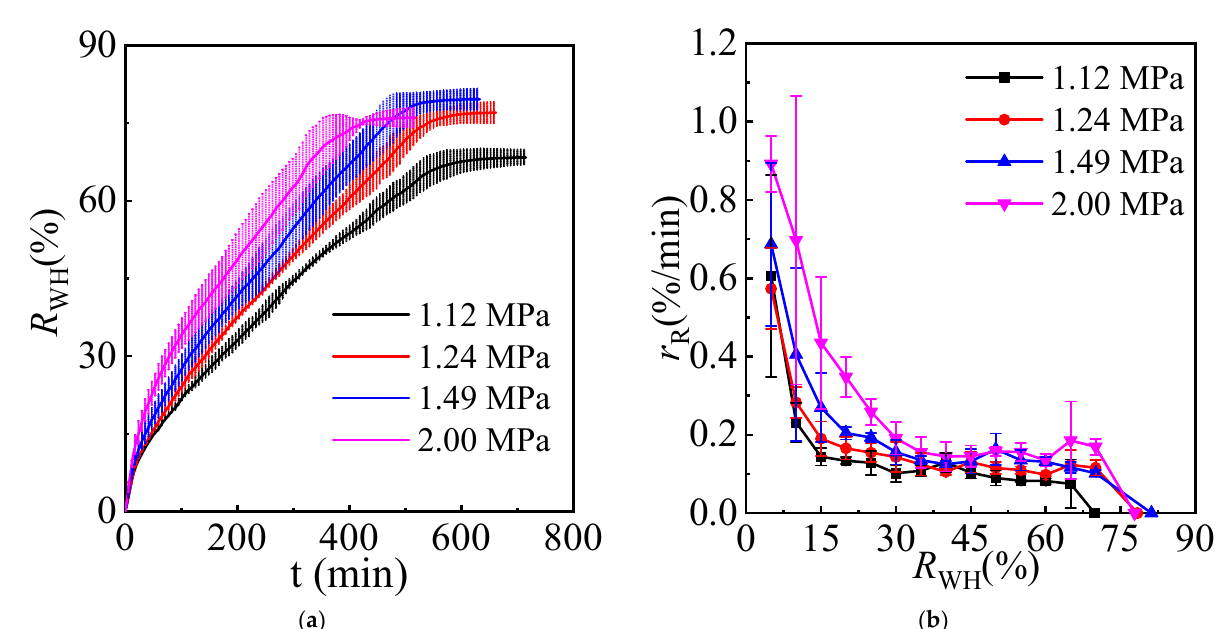
Figure 5. The kinetic data of hydrate formation under different pressure at 278.15 K with the w p,0 of 0.10 mass%: ( a ) R WH vs. time; ( b ) r R vs. R WH .